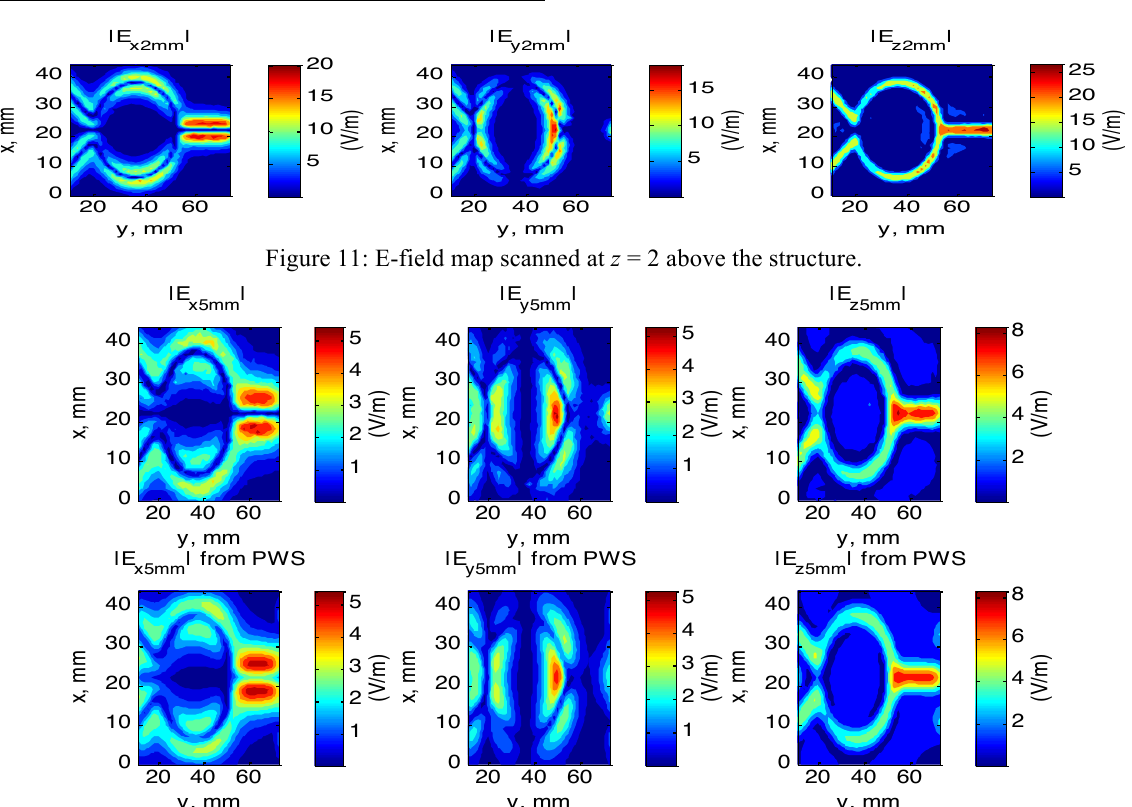
Figure 12: Comparison between the measured E-field maps scanned at z = 5 mm and those calculated from the PWS method proposed.